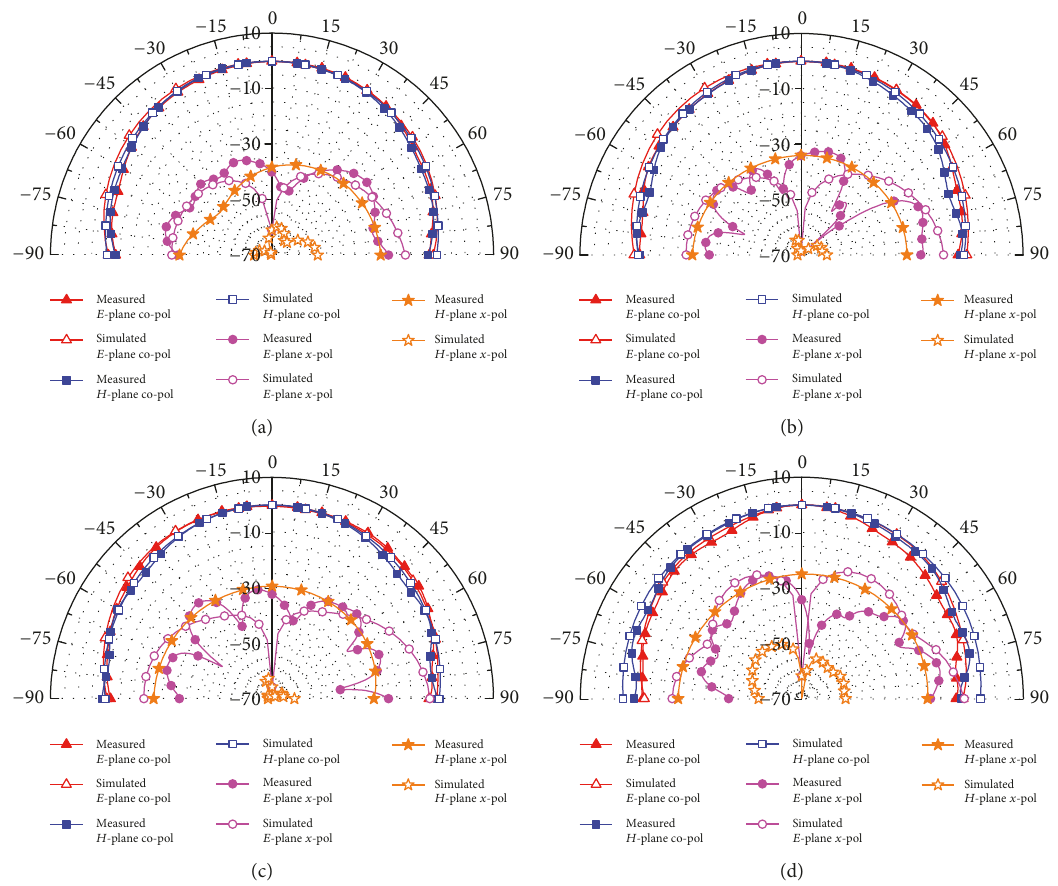
Figure 14: The simulated and measured normalized radiation patterns of the antenna in Figure 9(b): (a) 0.55 GHz, (b) 0.65 GHz, (c) 0.75 GHz, and (d) 0.85